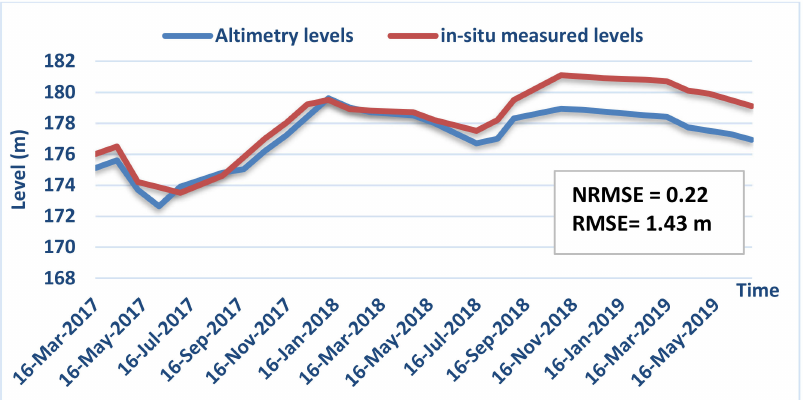
Figure 5. Difference between in situ measured water levels and Sentinel-3 satellite altimetry water levels for AHDL in the period between 2016 to